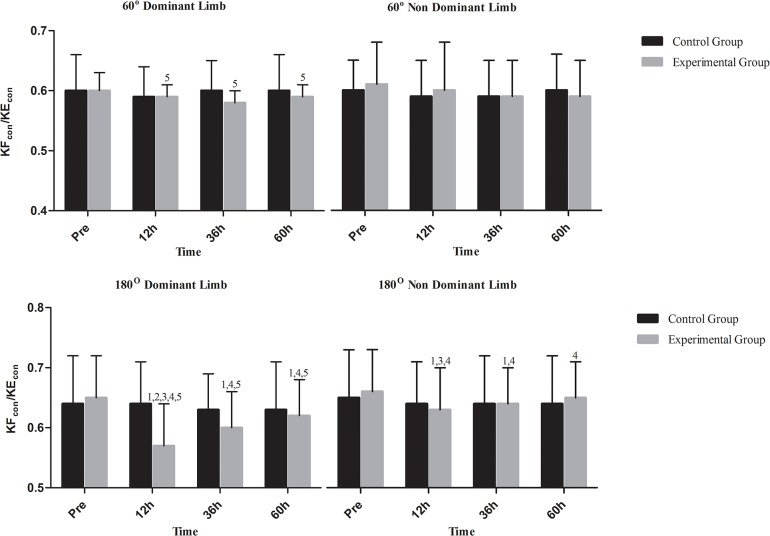
Changes of conventional ratio in response to a football match.KFcon/KEcon, conventional ratio; h, hours; 1Significant difference with baseline; 2significant difference between groups; 3significant difference between dominant and non-dominant limb at corresponding time; 4greater decline in functional ration compared to conventional ratio at corresponding time;5greater decline at 180°/s compared to that at 60°/s at corresponding time.